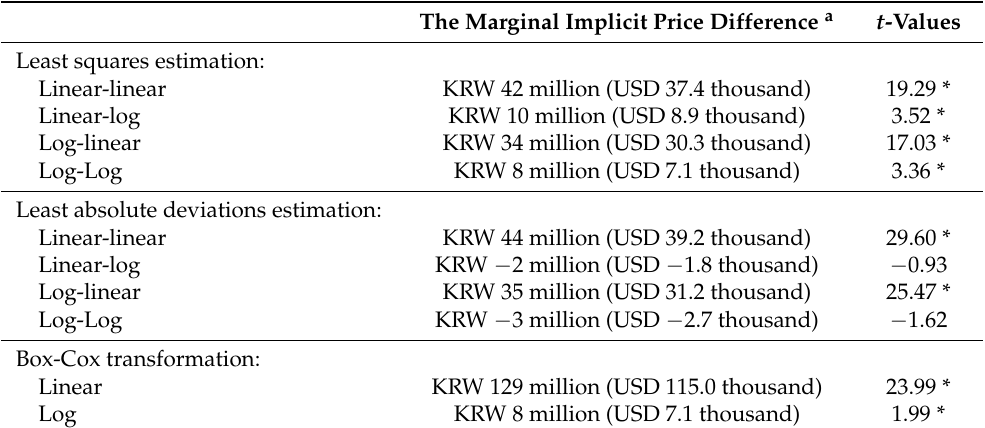
Table 3. Changes in housing prices caused by the direct distance from a power plant to the house. The Marginal Implicit Price Difference a t